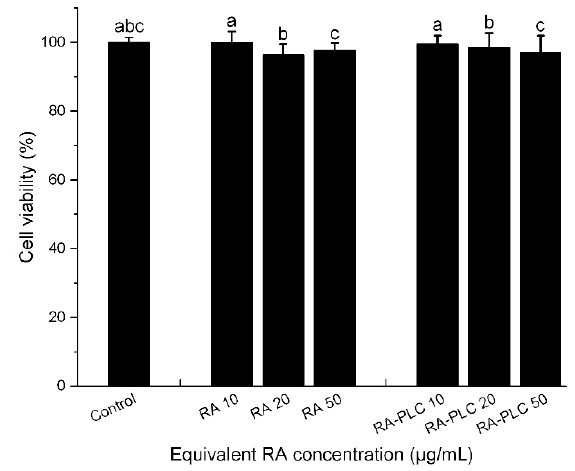
Figure 4. Cell viability (%) of RA and RA-PLC at different concentrations. Shared letters indicate no significant difference in cell viability between compared samples ( n = 3, mean ± SD).